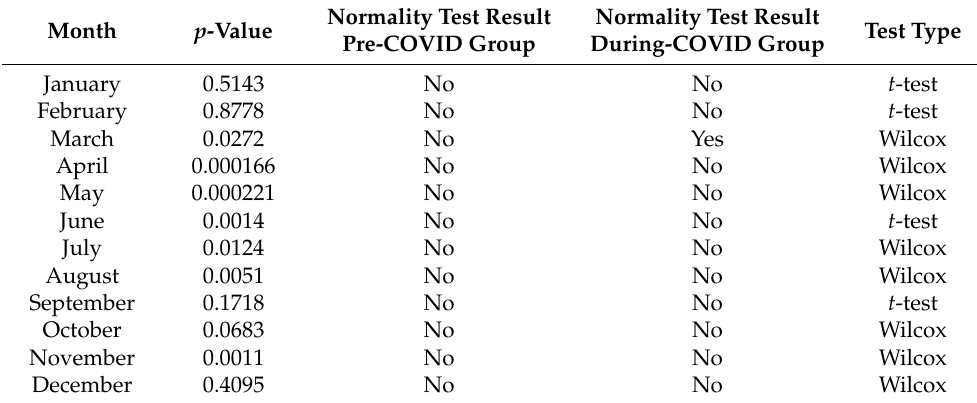
Table A2. Statistical values for H04 for each month.